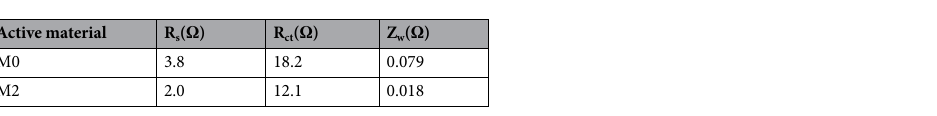
Table 2. The derived impedance parameters of M0 and